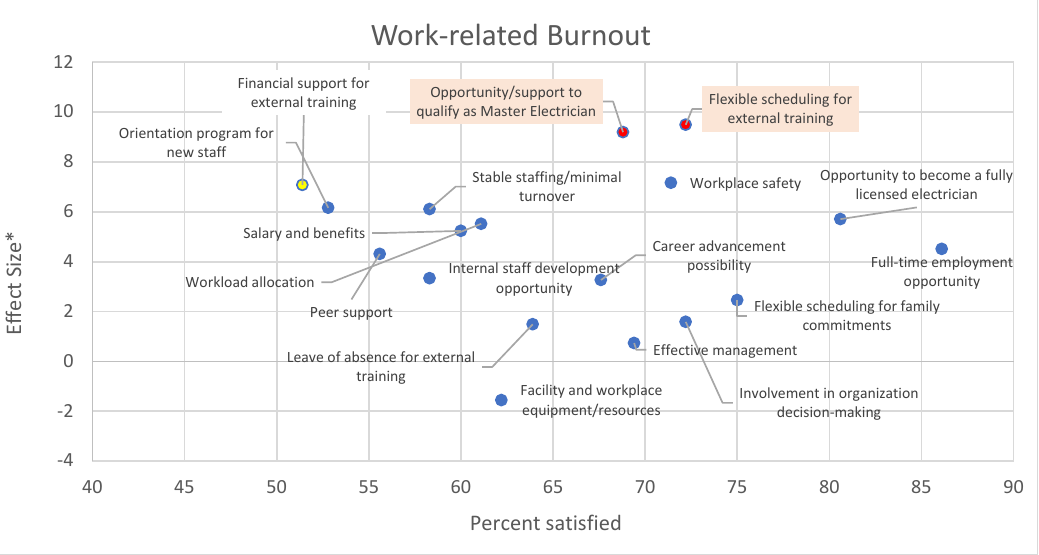
Figure 4. Impact of availability of work-related factors on work-related burnout. * Effect sizes is the difference in the average burnout score among those satisfied and those dissatisfied with the factor. Thus, positive effect sizes indicate higher burnout among those dissatisfied with the factor. The proportion satisfied is a measure of performance that indicates the proportion of the sample that stated to be satisfied or very satisfied with the availability of the factor. The red dots indicate statistical significance at an alpha level of 0.10 when comparing the average burnout score among respondents satisfied and dissatisfied with the factor.